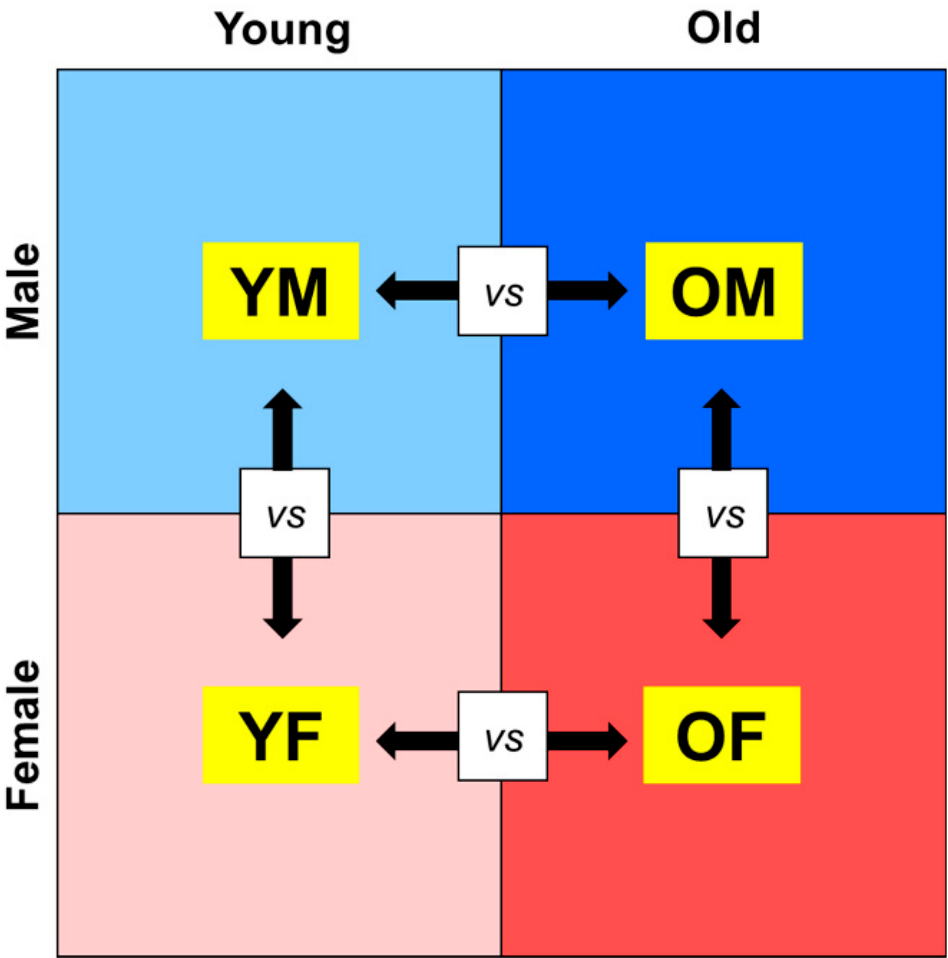
Figure 1. Study designs for transcriptomic analysis of age and sex differences. RNA-Seq data of rat liver tissues were categorized into four groups, and DEGs were calculated by two groups. OM, old male; YM, young male; OF, old female; YF, young female.